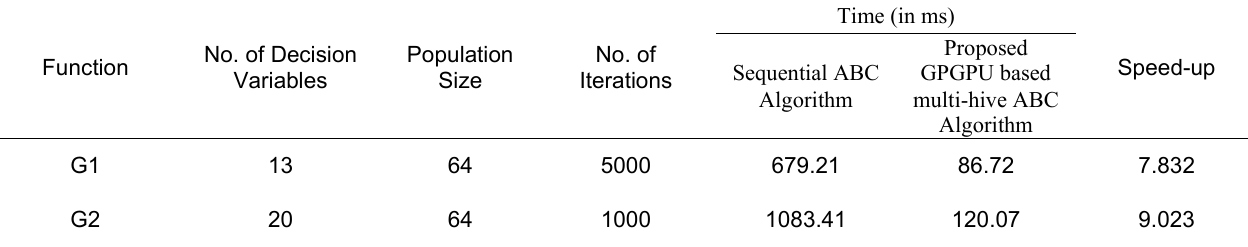
Table 5. Execution time and Device utilization of GPGPU based multi-hive ABC algorithm